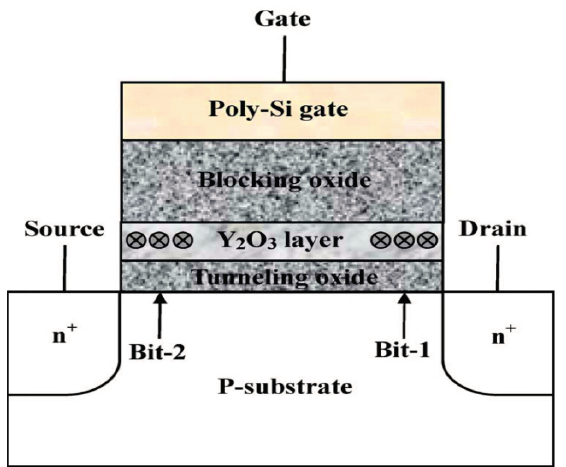
Figure 8. Schematic representation of flash memory cell structure using the Y charge-trapping layer. Reused with permission from [43], Copyright 2008,